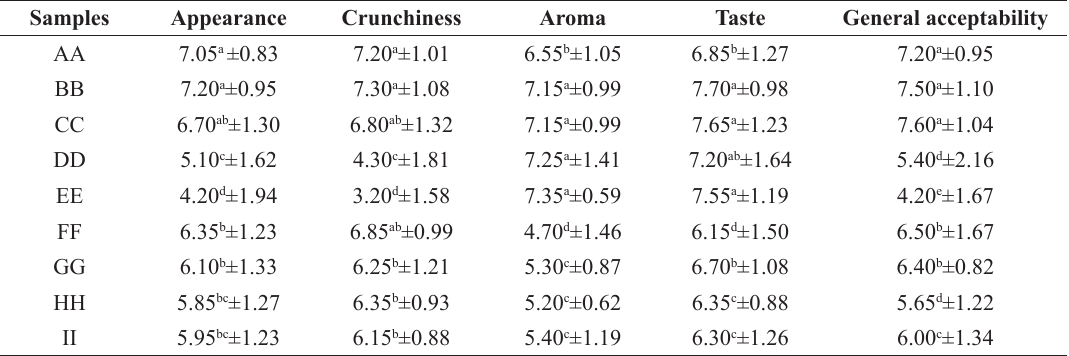
Table 5: Mean Sensory score of snacks of different blends of maize and groundnut.